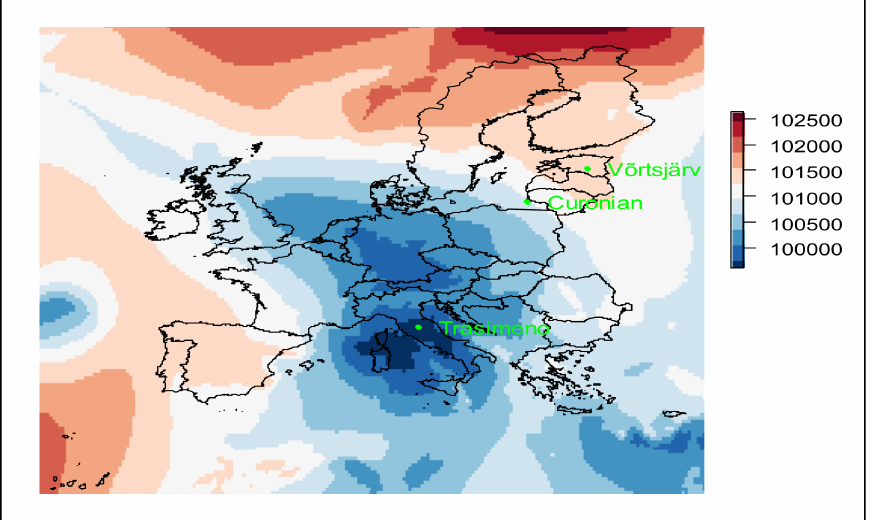
Figure 1. Map of Europe showing the three WISPstation sites together with atmospheric pressure (Pa) on the 28 July 2019 indicating the weather system that marked the end of the July